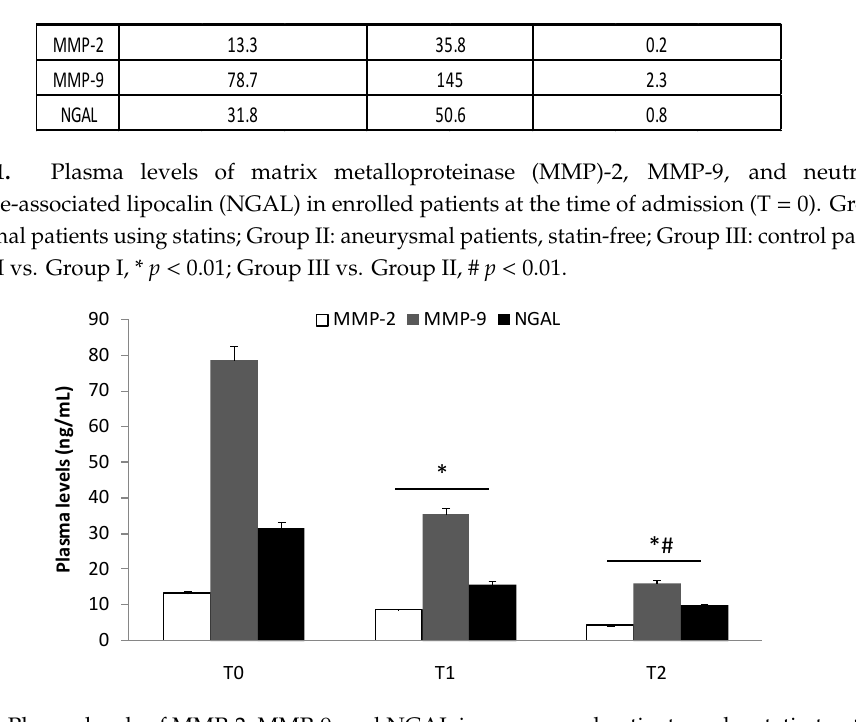
Figure 2. Plasma levels of MMP-2, MMP-9, and NGAL in aneurysmal patients under statin treatment (Group I) at the time of admission (T0) and 1 (T1) and 3 (T2) months later. T1 vs. T0, * p < 0.01; T2 vs. T1, # p < 0.01.